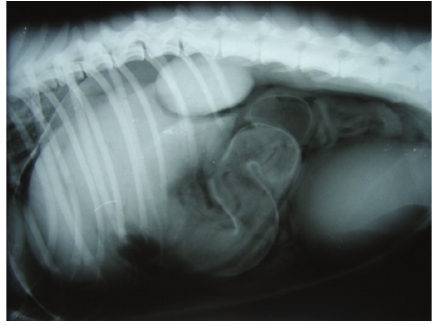
Figure 5: Right lateral capnoperitoneograph enhancing visualiza- tion of left liver lobes and diaphragmatic border in 8-year-old male Dobermann Pinscher dog demonstrating classical signs of pulmonary metastasis with strong suspicion for hepatic neoplasia.